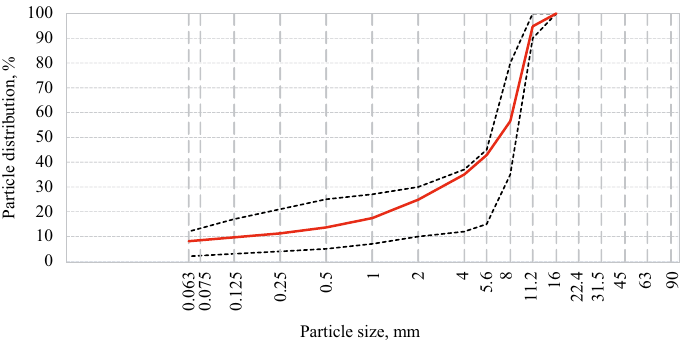
Figure 1. Particle distribution of the unbound material mixture